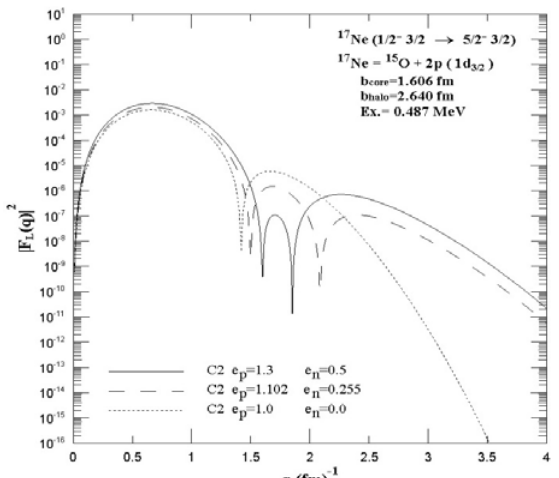
Fig. 10: The calculated inelastic longitudinal C2 form factors of 17 Ne with two protons in orbit and for ( 2325   TJ  ) state. 1d 3/2